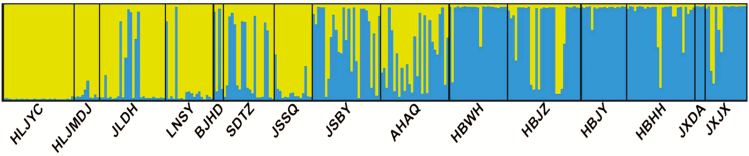
Proportions of ancestry of 15 Zizania latifolia populations based on K = 2 subdivisions. Each bar represents the proportional membership assignments of an individual.